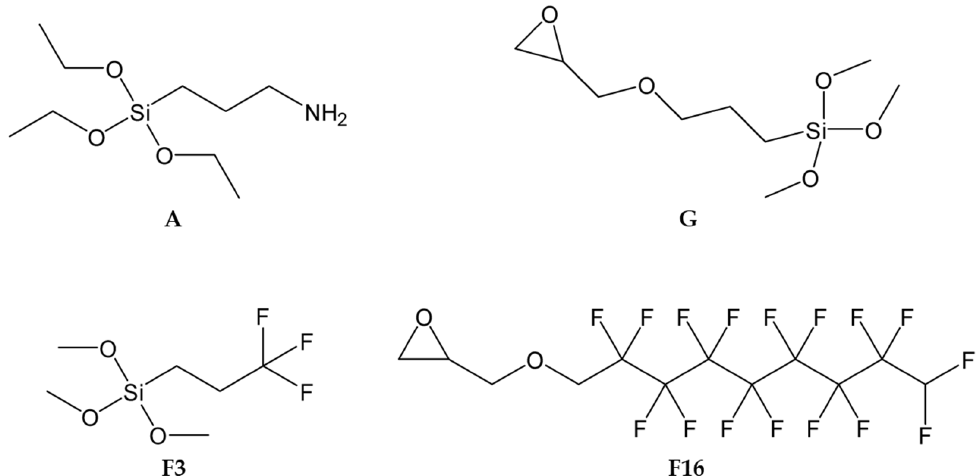
Figure 2. Chemical structure of the employed functional alkoxysilane sol–gel precursors together with the adopted acronyms.